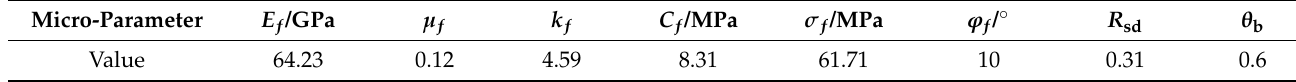
Table 8. The microscopic parameters are finally determined.